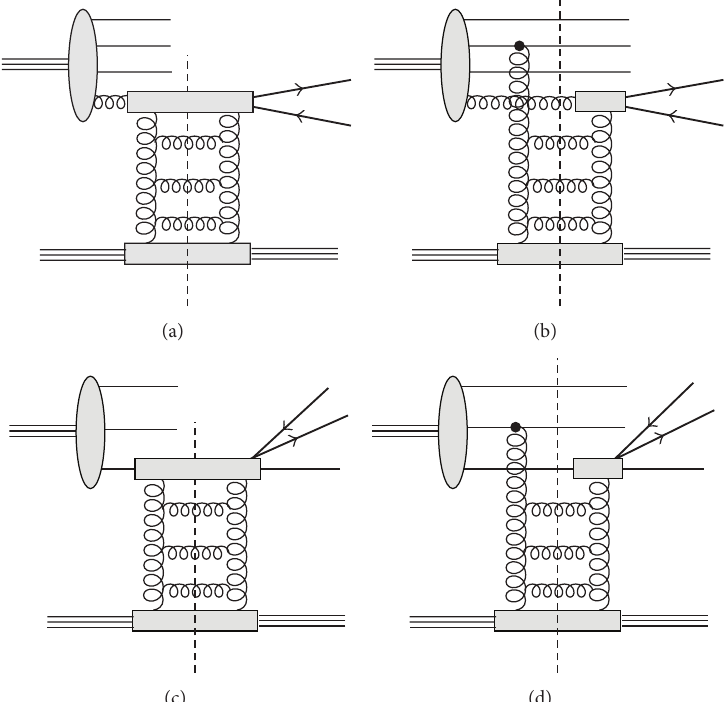
Figure 12: Leading order contributions to single diffractive heavy flavor production in gluon-proton (a, b) and quark-proton (c, d) scattering subprocesses in 𝑝𝑝 collisions. Diagrams (b, d) emerge due to the presence of soft spectator partons in the proton wave function (the screening gluon couples to every spectator parton besides the active one). Grey effective vertices account for all possible couplings of the incident partons.